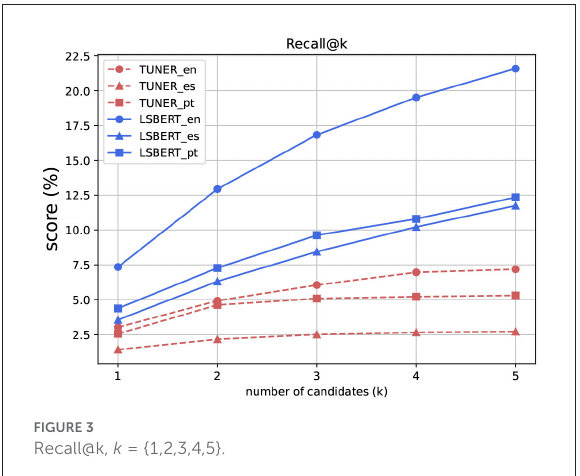
FIGURE3 Recall@k, k = {1,2,3,4,5}.